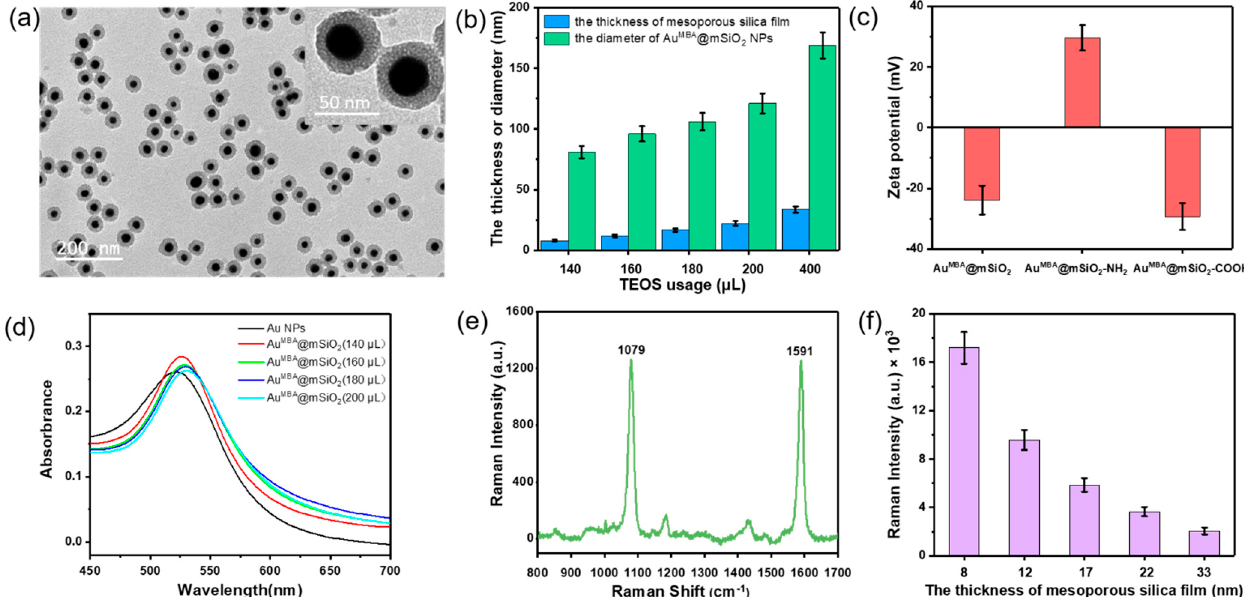
Figure 2. Characterization results of the Au MBA @mSiO 2 NPs and corresponding SERS nanotags. ( a ) TEM images of Au MBA @mSiO 2 NPs (TEOS usage: 140 µ L). ( b ) During the preparation of Au MBA @mSiO 2 NPs, the relationship between TEOS usage (140, 160, 180 and 200 µ L) and the thickness of mesoporous silica film and the diameter of Au MBA @mSiO 2 NPs (measured by a ZetaSizer) was evaluated. Error bars represent the standard deviation (N = 50). ( c ) During the preparation of SERS nanotags, the zeta potentials of Au MBA @mSiO 2 , Au MBA @mSiO 2 -NH 2 , Au MBA @mSiO 2 NPs (N = 10) were measured. ( d ) UV-vis absorption spectra of Au NPs and Au MBA @mSiO 2 nanoparticles with different TEOS usage. ( e ) Raman spectra of Au MBA @mSiO 2 NPs (TEOS usage:140 μ L) characterized by a confocal Raman spectrometer. ( f ) The relationship between total Raman intensities at 1079 cm − 1 of ten Au MBA @mSiO 2 NPs and the thickness of mesoporous silica film.